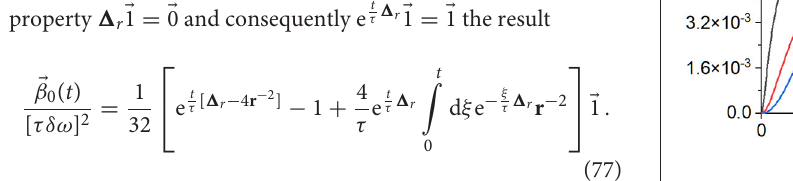
FIGURE 2 | Time evolution of the GLP moment functions α 2 ( r , t ) (A) , β 0 ( r , t ) (B) , and β 4 ( r , t ) (C) at the discretized radial points R C , R M R D for τδω 10 and η = =